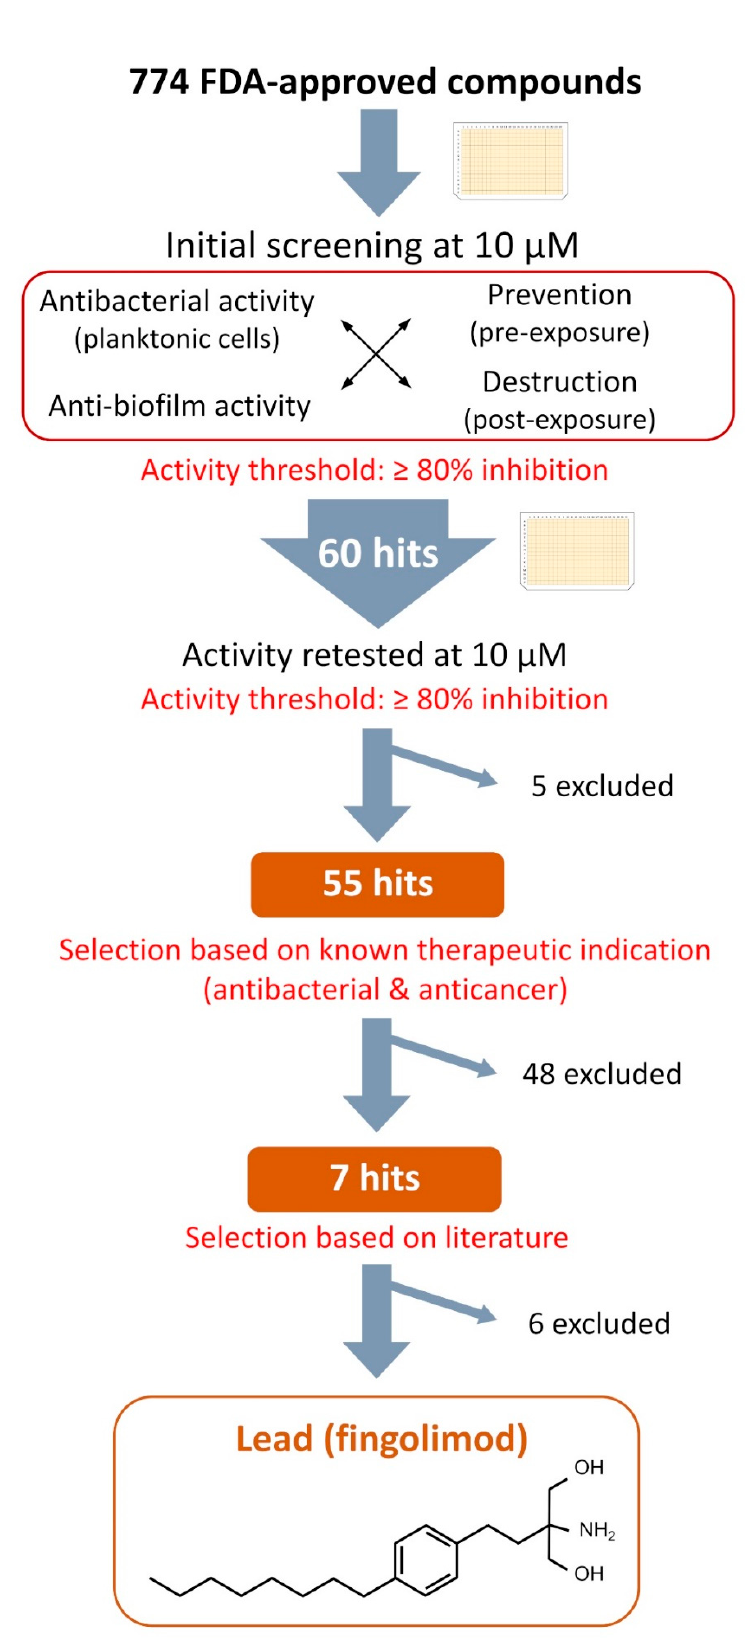
Figure 2. Selection process from the initial screening of the compound library to the selection of the lead and chemical structure of fingolimod.